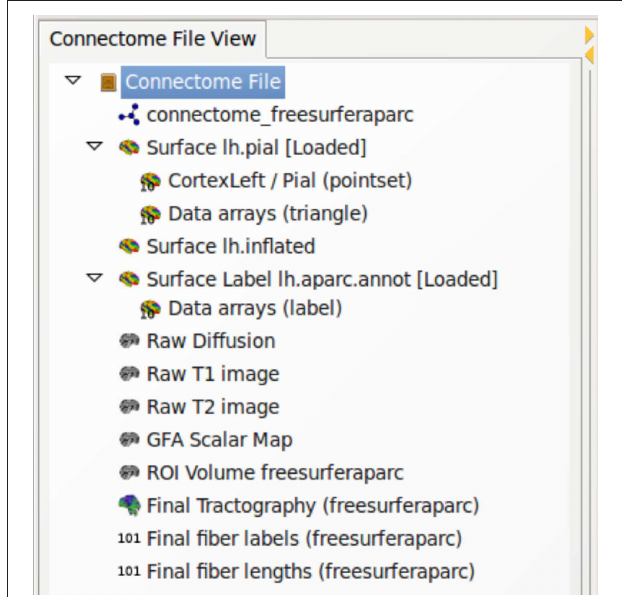
Figure 7 | Connectome File View as a Connectome Viewer widget. The treeview gives a convenient user interface to deal with connectome objects contained in a connectome file. Data files are loaded into memory by double-clicking. Single tree nodes can be dragged to the IPython shell for data inspection and